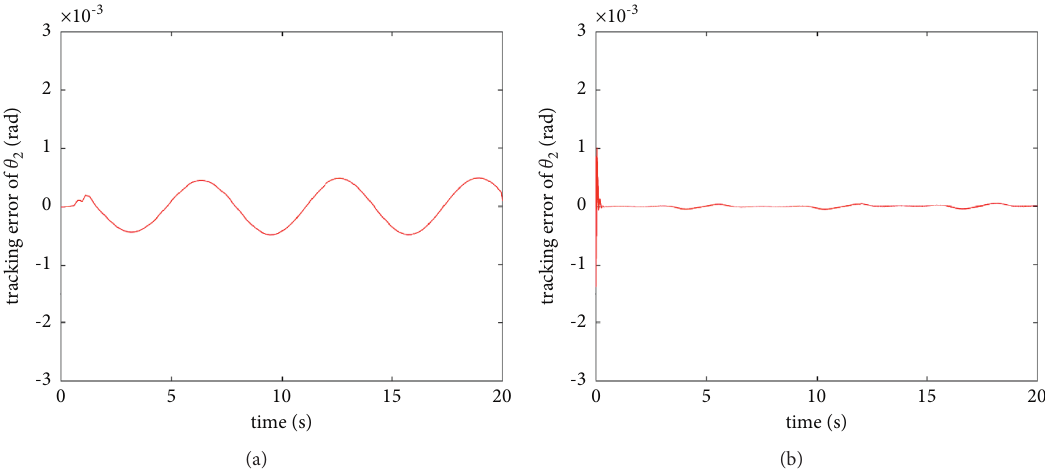
Figure 5: The tracking error of θ under the action of (a) backstepping control and (b) NN-based backstepping 2